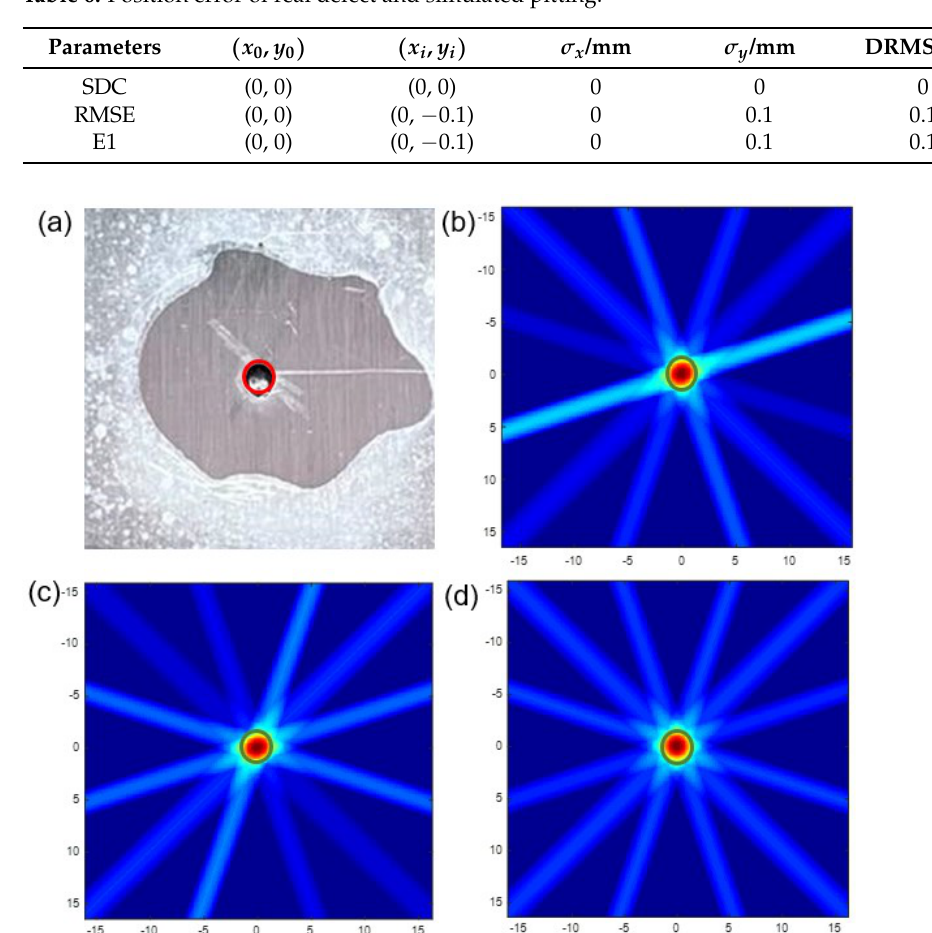
Table 6. Position error of real defect and simulated pitting.